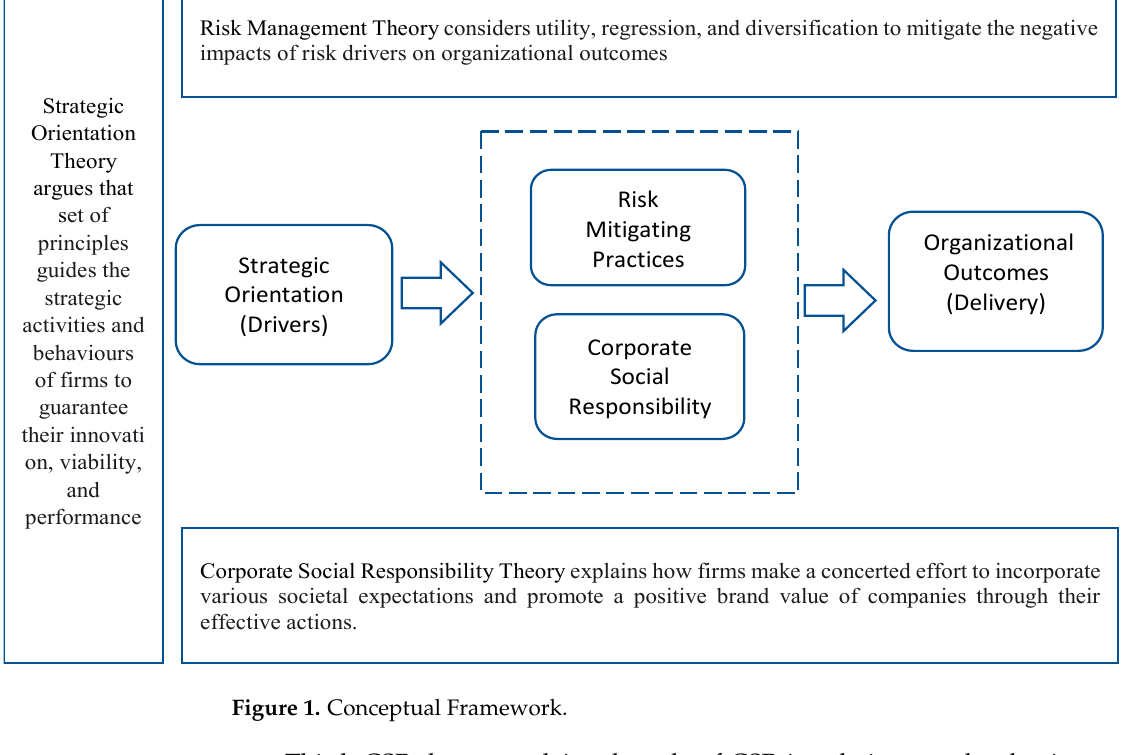
Figure 1. Conceptual Framework.